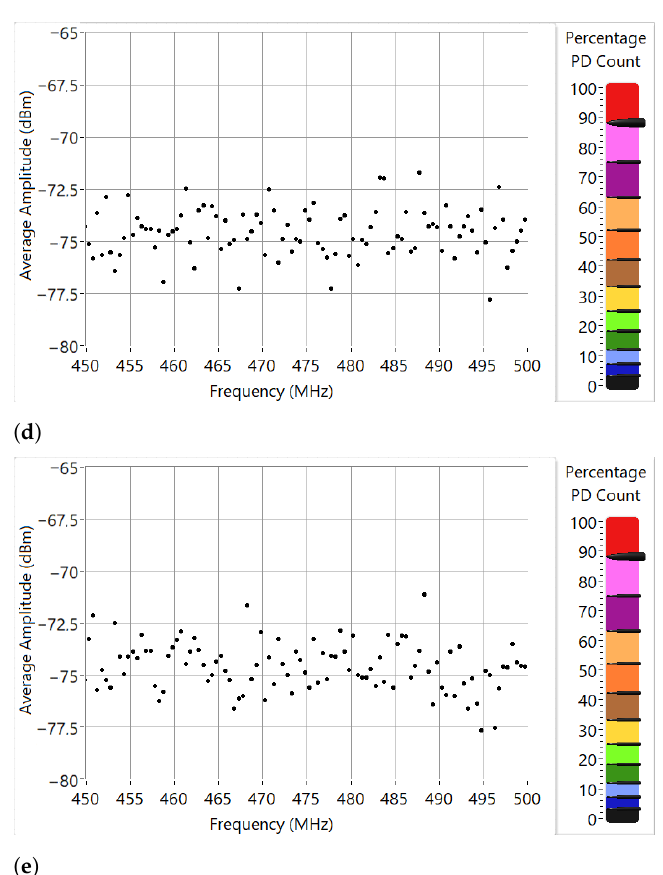
Figure 19. FRPD for different cases, from 450 to 500 MHz: ( a ) corona, ( b ) slot, ( c ) corona with slot, ( d ) noise with the power supply not energized, and ( e ) noise with energized power